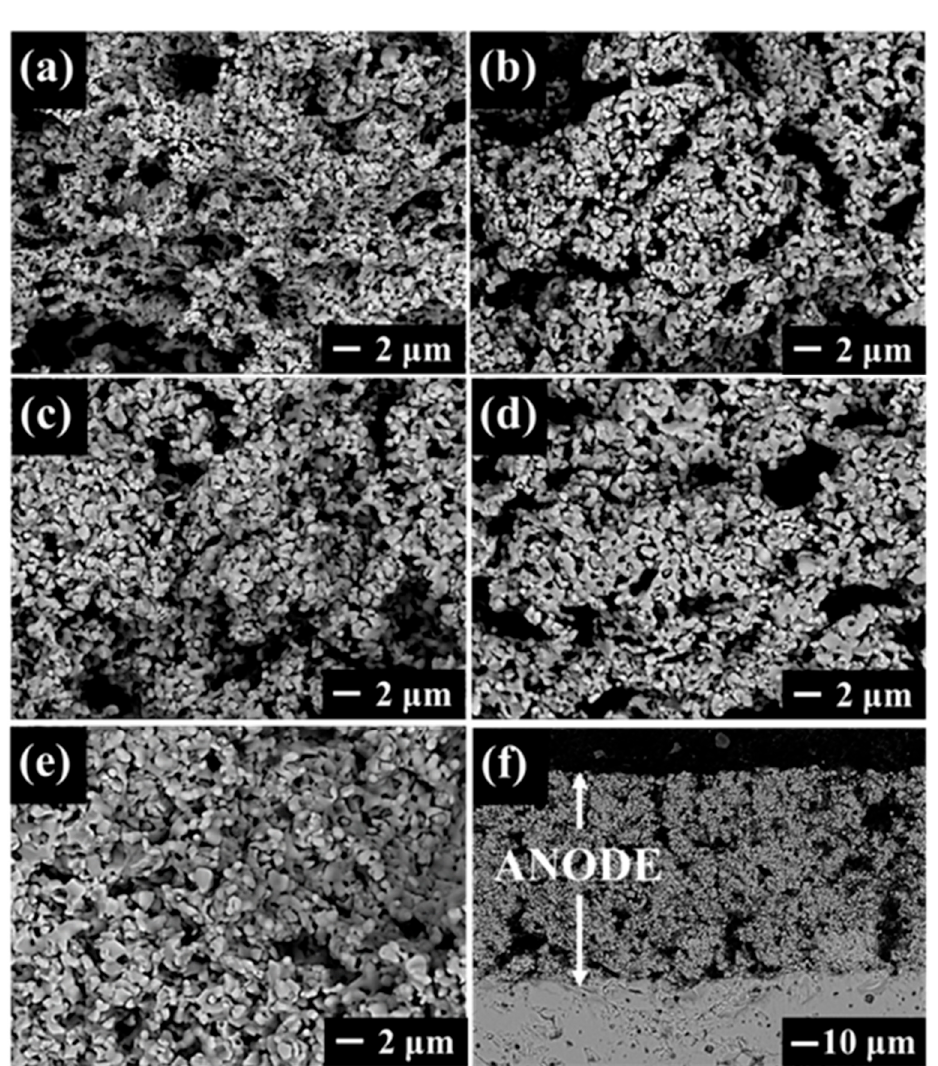
Figure 2. Backscattered electron images of the cross sections of the Ni 1 − X Co X / YSZ cermets: ( a ) x = 0, ( b ) x = 0.05, ( c ) x = 0.15, ( d ) x = 0.25, ( e ) x = 0.50 and ( f ) x = 0.25 with the YSZ electrolyte disk.